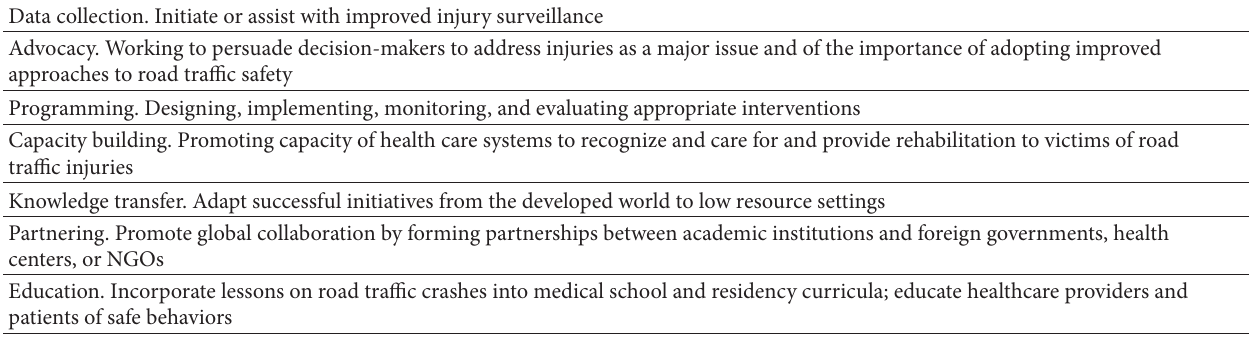
Table 2: Key points for global road traffic injury prevention (WHO, 2004)